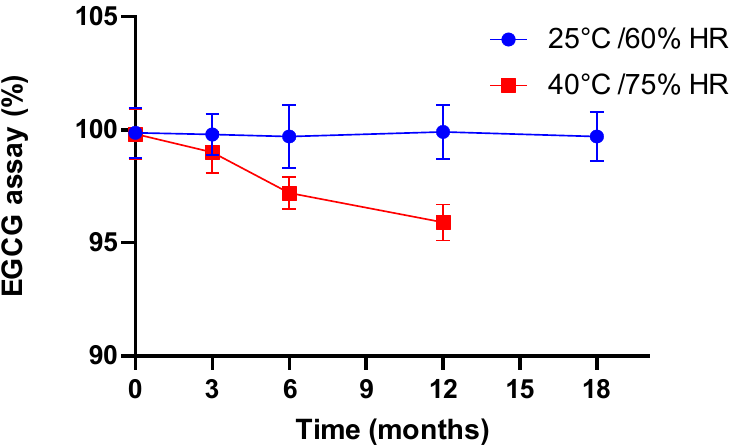
Figure 4. ( a ) Chromatographic profile of the formulation at time 0. ( b ) Chromatographic profile of the formulation after 18 months under standard conditions. ( c ) Chromatographic profile of the formulation after 6 months under accelerated conditions.